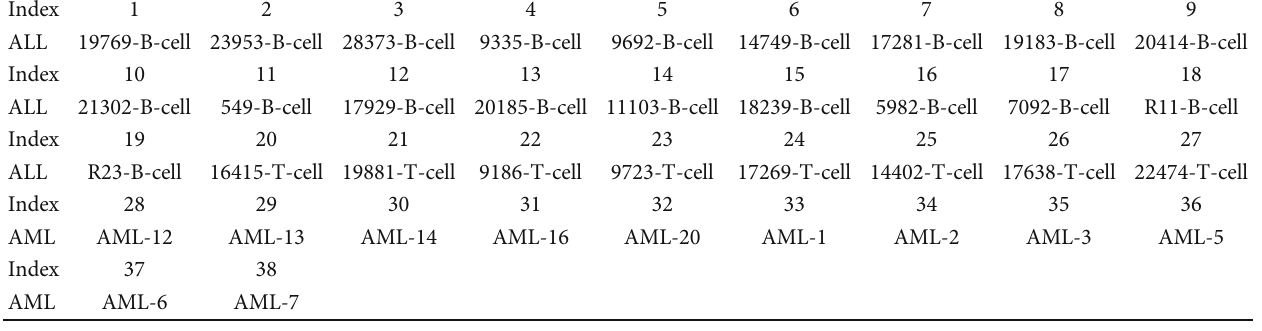
Table 1: Original indices of columns of Golub ’ s ALL-AML leukemia